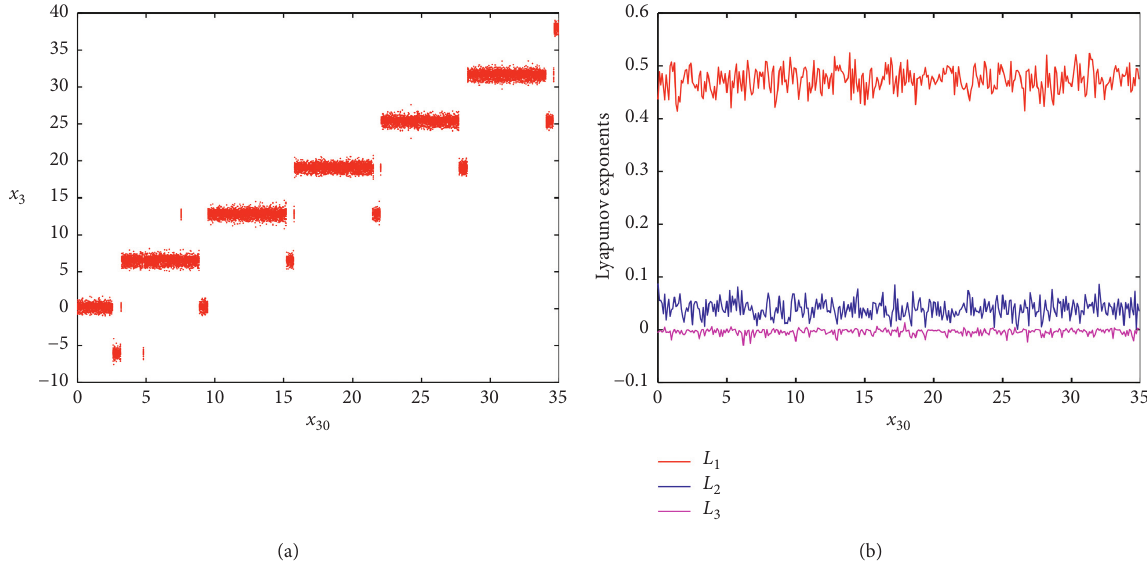
Figure 7: Bifurcation diagram and Lyapunov exponent of system (2) with a � 4, b � c � 1, k � 12, and x are Lyapunov exponents of system (2) and L